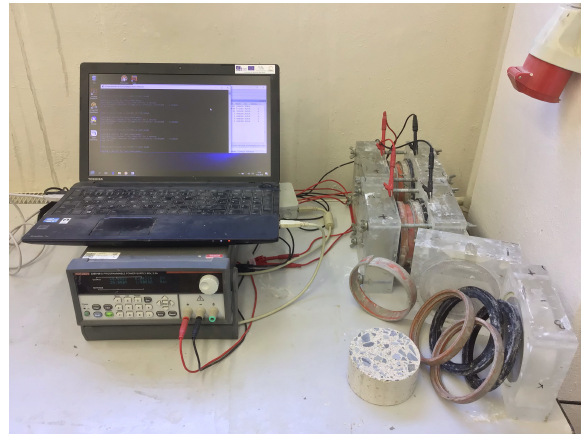
Figure 1. An electromigration setup used for accel- erated chloride penetration/extraction